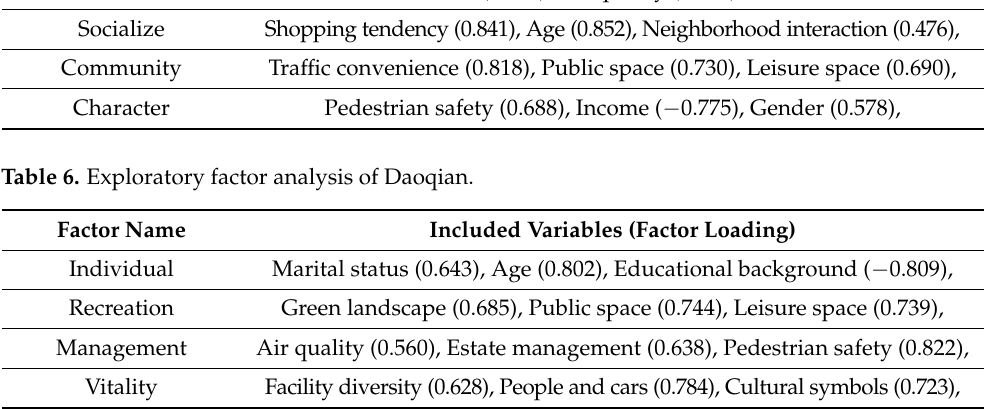
Table 5. Exploratory factor analysis of Nanhuan.